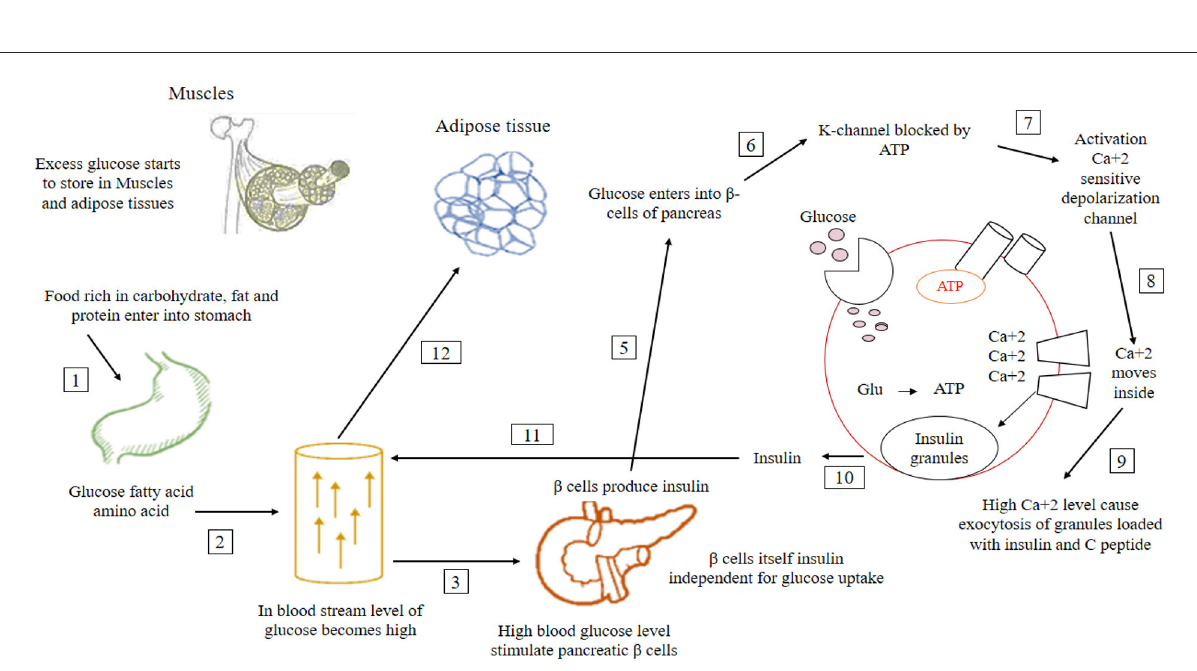
FIGURE3 In normal conditions, after taking food, the glucose level of the blood increases. High glucose levels stimulate pancreatic β cells responsible for insulin production. After the activation of β cells, insulin level increases in the blood, which lowers glucose level to the normal range. When this insulin production is not enough for glucose utilization, glucose remains constant in the blood